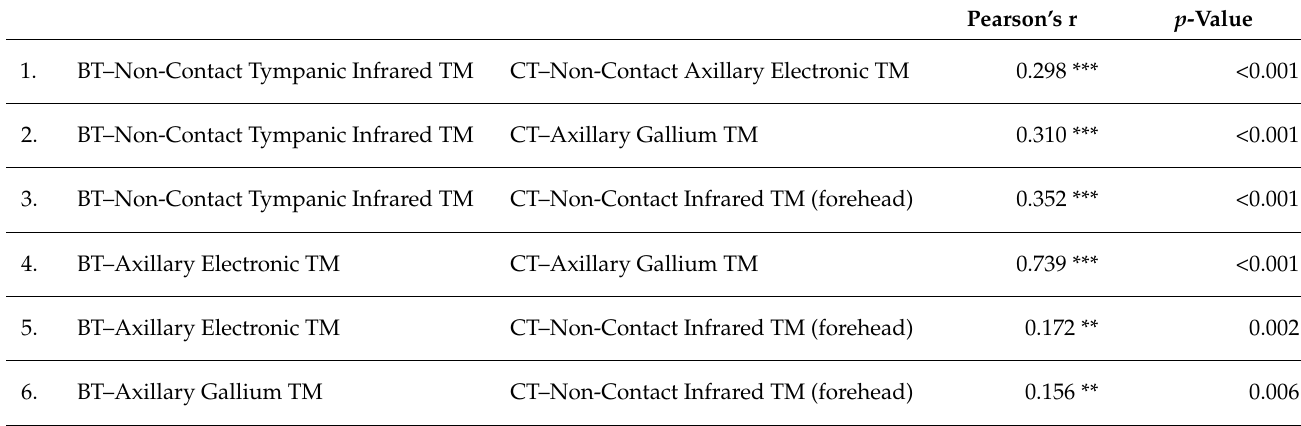
Table 8. Correlations: body temperature and different thermometers.